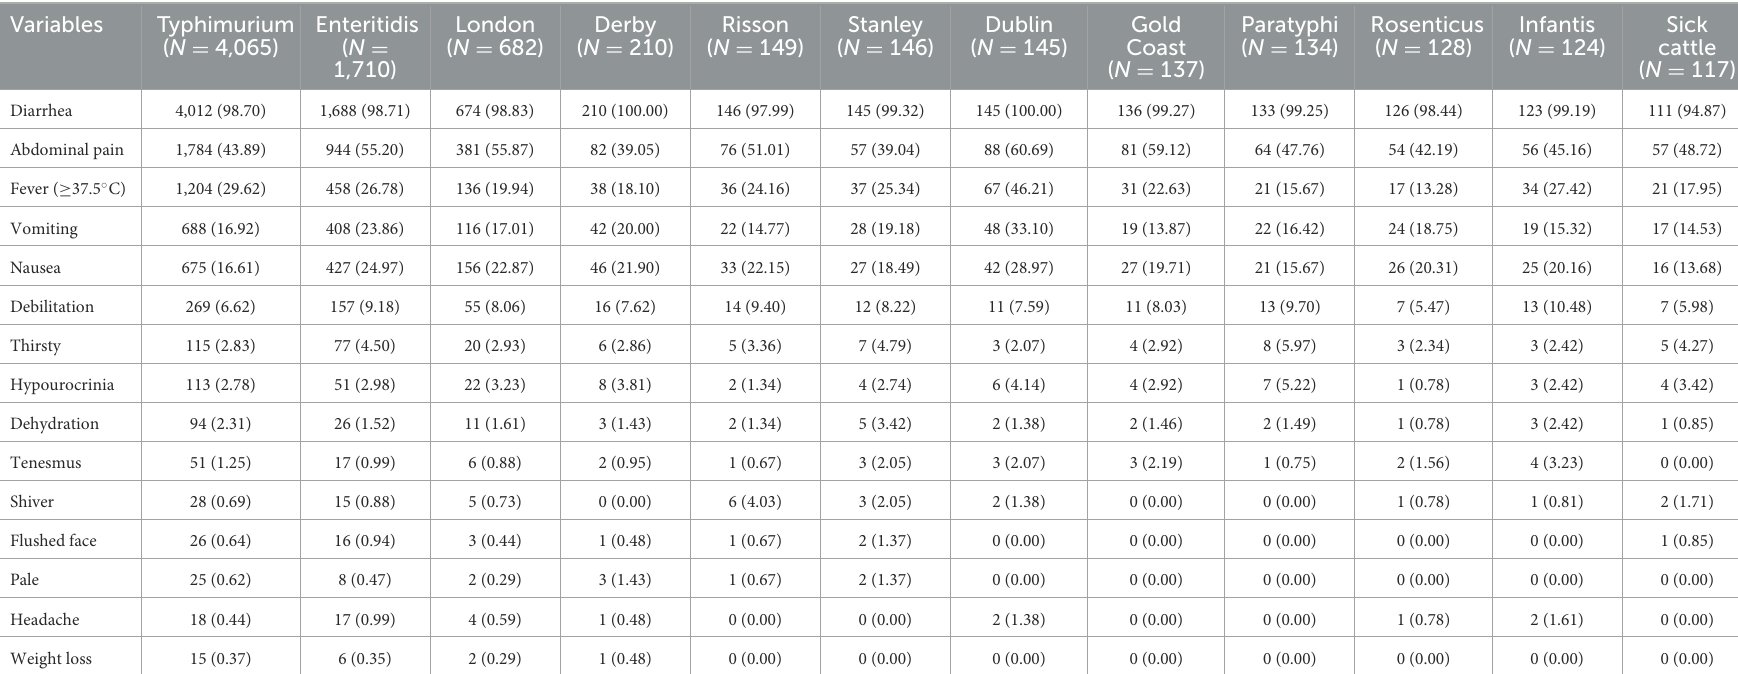
TABLE 3 Reported signs and symptoms of Salmonella cases in different